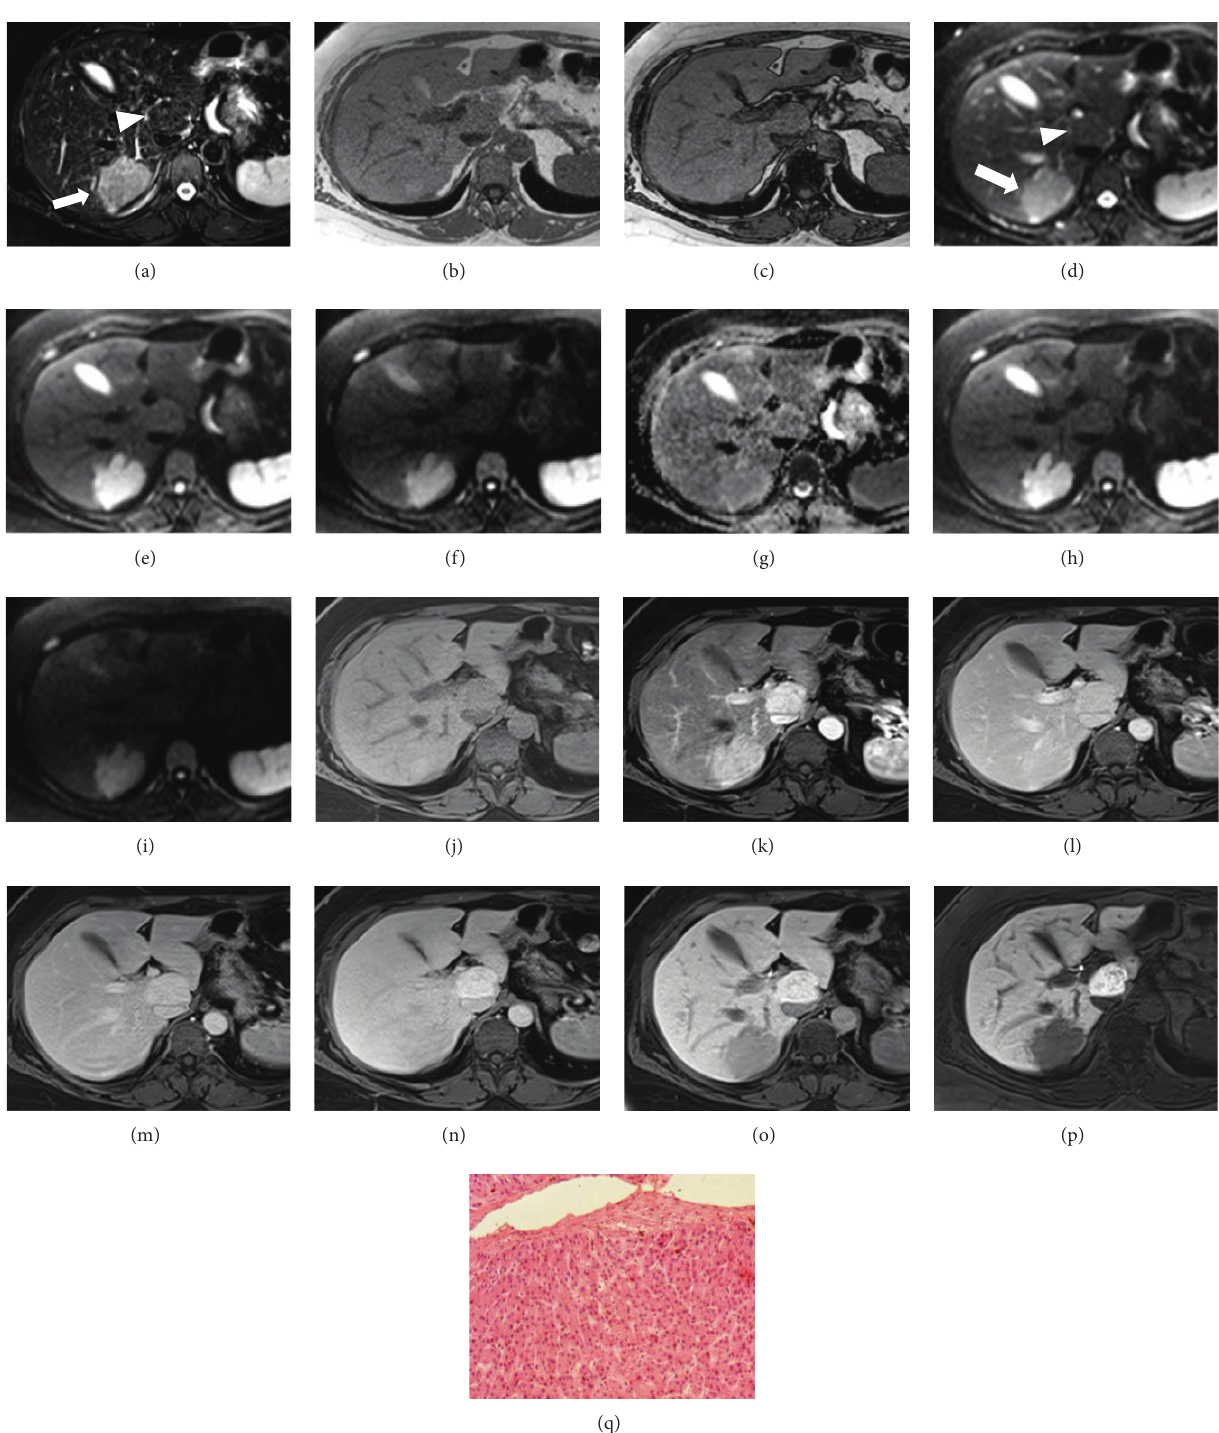
Figure 1: Inflammatory adenoma and focal nodular hyperplasia. (a) Axial T2w fat-suppressed image. In Segment (S) VII homogeneous well- delineated hyperintense adenoma (arrow), proven by biopsy. In SI, note a second isointense lesion, focal nodular hyperplasia (arrowhead). (b- c) T1w in- and out-phased images. Both lesions are mainly isointense. (d–i) DWI sequences. Adenoma (arrow in d) is constantly hyperintense. Conversely FNH (arrowhead in d) is isointense. ADC map (i) both lesions are is slightly hyperintense. (j–n) In dynamic evaluation after Gd- EOB-DTPA administration adenoma shows intense enhancement in arterial phase (k) with washout in portal (l) and equilibrium (m) phases; conversely, FNH shows progressive increase of the signal. (o-p) In hepatobiliary phases after 10 󸀠 (o) and 20 󸀠 (p), adenoma is hypointense relative to the adjacent liver parenchyma and FHN is hyperintense. (o) Histology shows hepatocytes arranged in plates that are two to three cells thick separated by